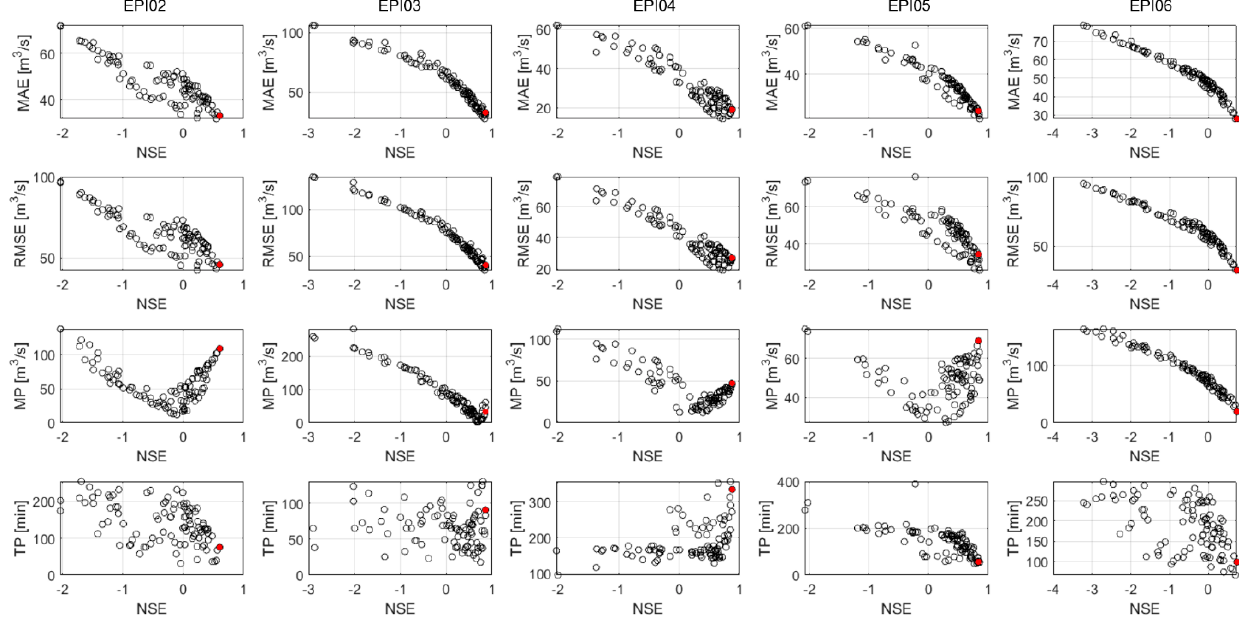
Figure 4. Objective function results for the five flood events considered in the calibration process. Columns show flood events. Rows show the relationship between each objective function and Nash–Sutcliffe efficiency coefficient ( NSE ). Red circles represent the combination of parameter values selected for the validation procedure.